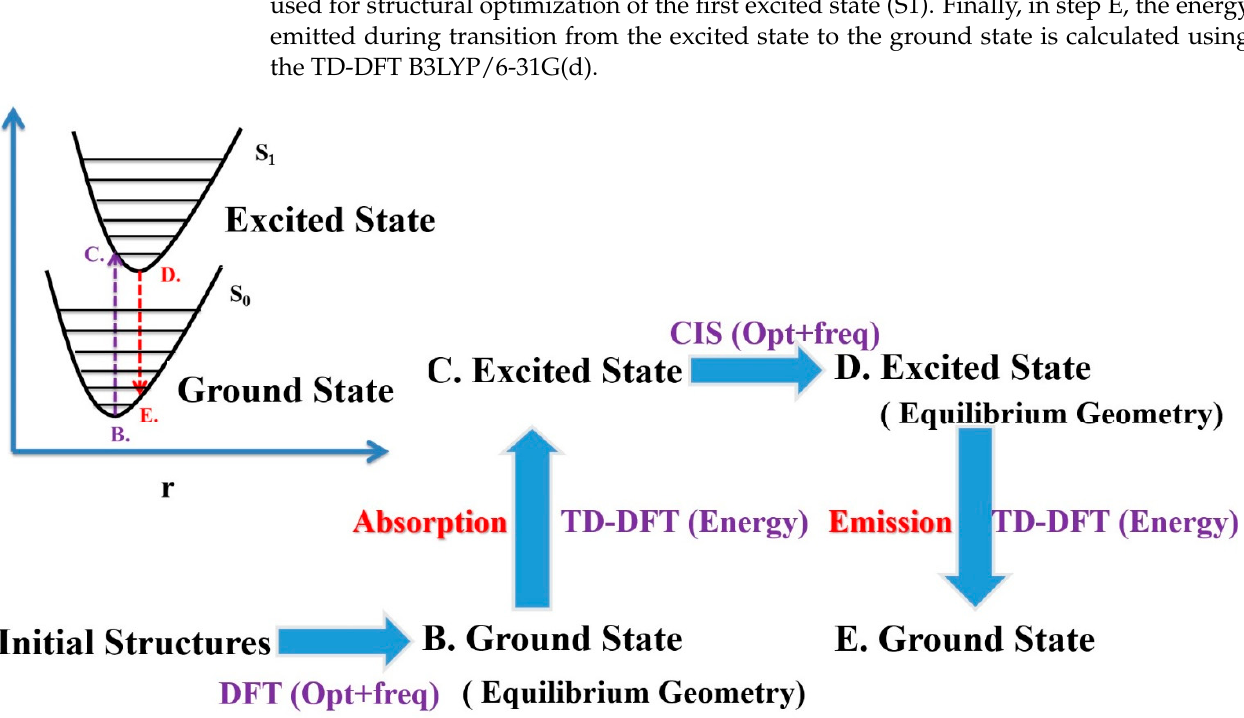
Figure 1. Steps in the calculation method.